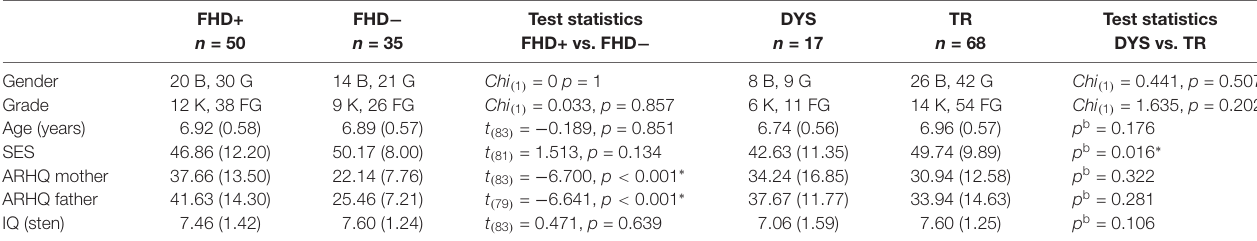
TABLE 1 | Demographic characteristics of FHD − and FHD+ participants, as well as dyslexic (DYS) and typical reading (TR) children together with group differences. FHD+ FHD − Test